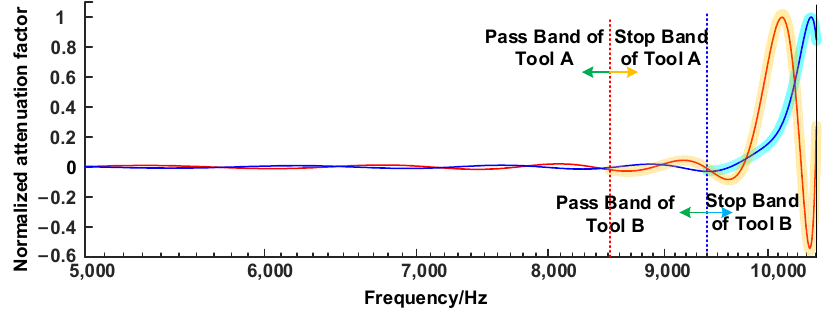
Figure 5. Normalized frequency attenuation factor of Tool A and Tool B.